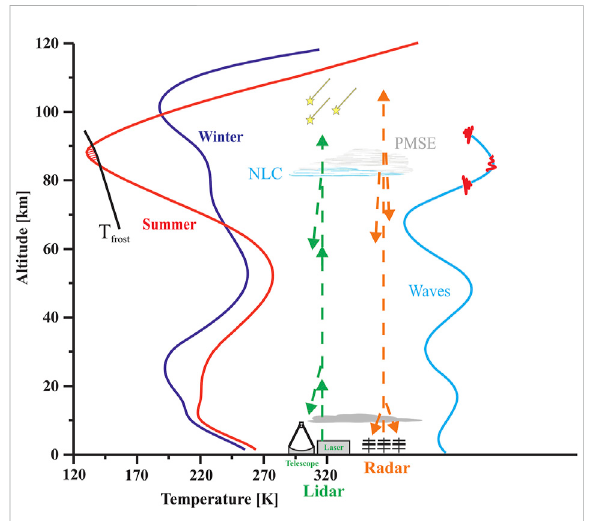
FIGURE 1 Temperaturepro fi lesathighlatitudes(70 ° N)forsummer(red) and winter(dark blue), respectively. Insummer, frost temperatures (black) in the mesopause region are larger than atmospheric temperatures. This allows for the existence of ice particles which are known as noctilucent clouds (NLC), and which are crucial for radar echoes known as polar mesosphere summer echoes (PMSE). The thermal structure in the MLT is mainly caused by a residual circulation driven by the interaction of the mean fl ow with gravity waves and